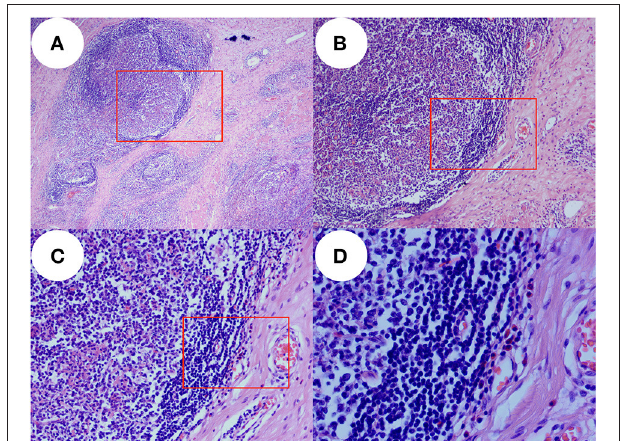
FIGURE 2 | Pathology images. In the proliferative fibrous tissue, there were proliferative lymphoid tissue, lymphoid follicles, a large number of eosinophils between the follicles, proliferative small vessels in the follicles, and local infiltration of striated muscle. Panel (A) is pathological images taken with an optical microscope at 40 × magnification and image (B) was taken at red rectangle. Panel (B) is pathological images taken with an optical microscope at 100 × magnification and image (C) was taken at red rectangle. Panel (C) is pathological images taken with an optical microscope at 200 × magnification and image (D) was taken at red rectangle. Panel (D) is pathological images taken with an optical microscope at 400 × magnification which show many eosinophils in the tissue.